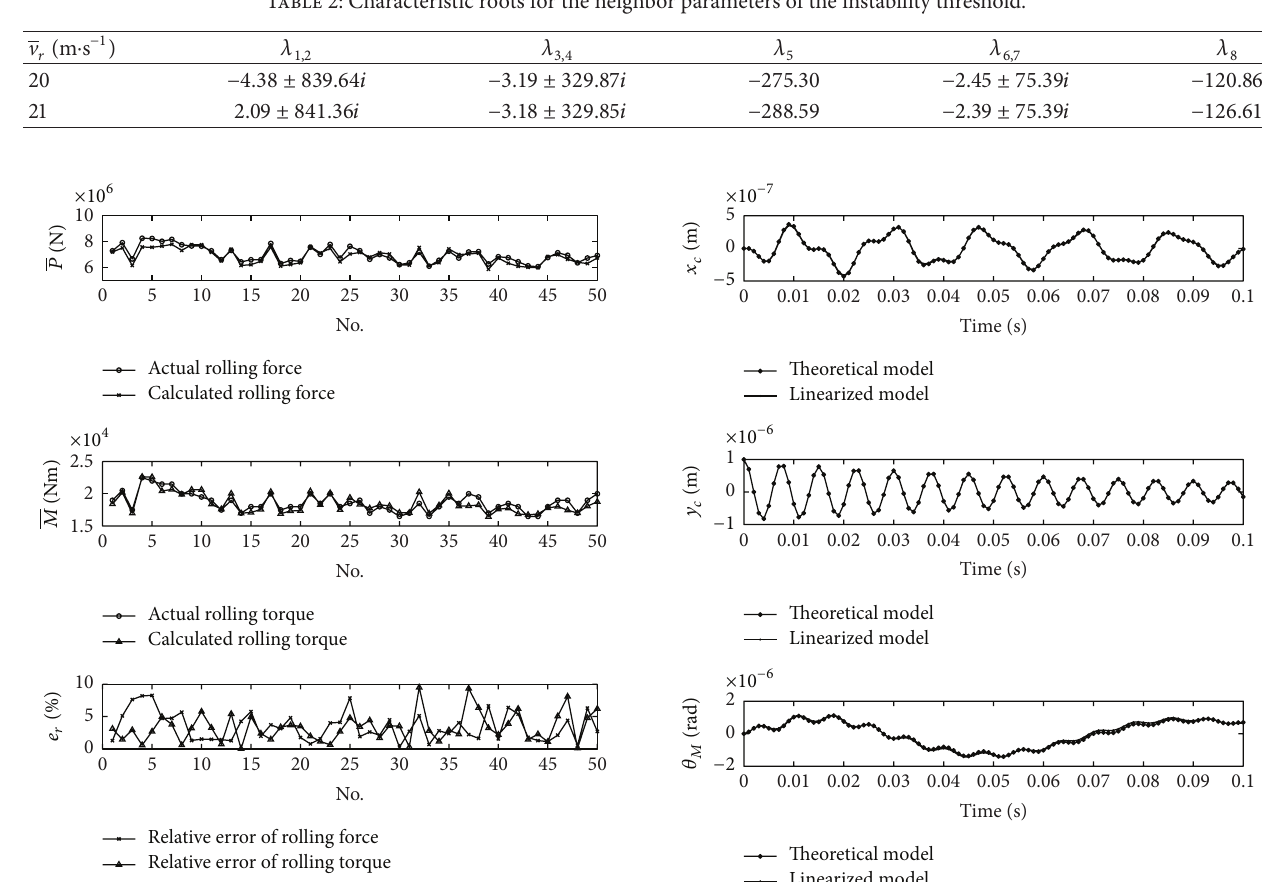
Table 2: Characteristic roots for the neighbor parameters of the instability threshold.